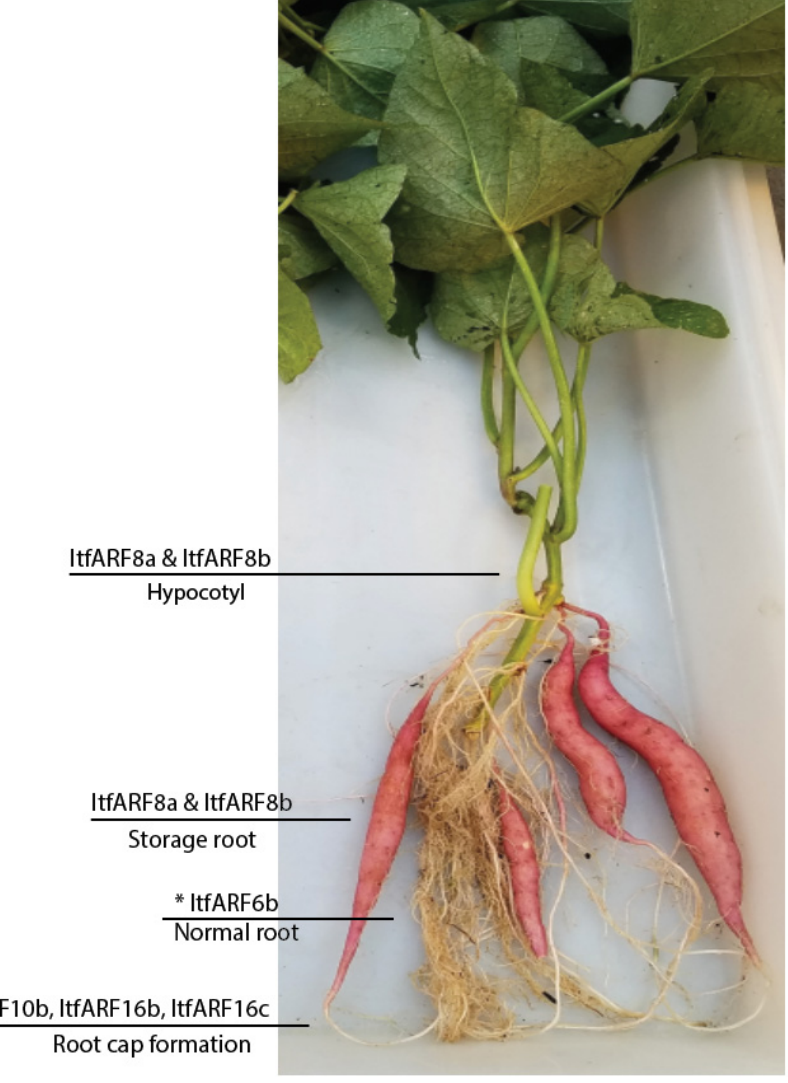
Figure 5. Five-week-old I. batatas normal root and storage root samples. Areas labeled correspond to where those genes are most likely expressed. An * denotes ItfARF8a and ItfARF8b, as their function is predicted to affect overall root growth and development.